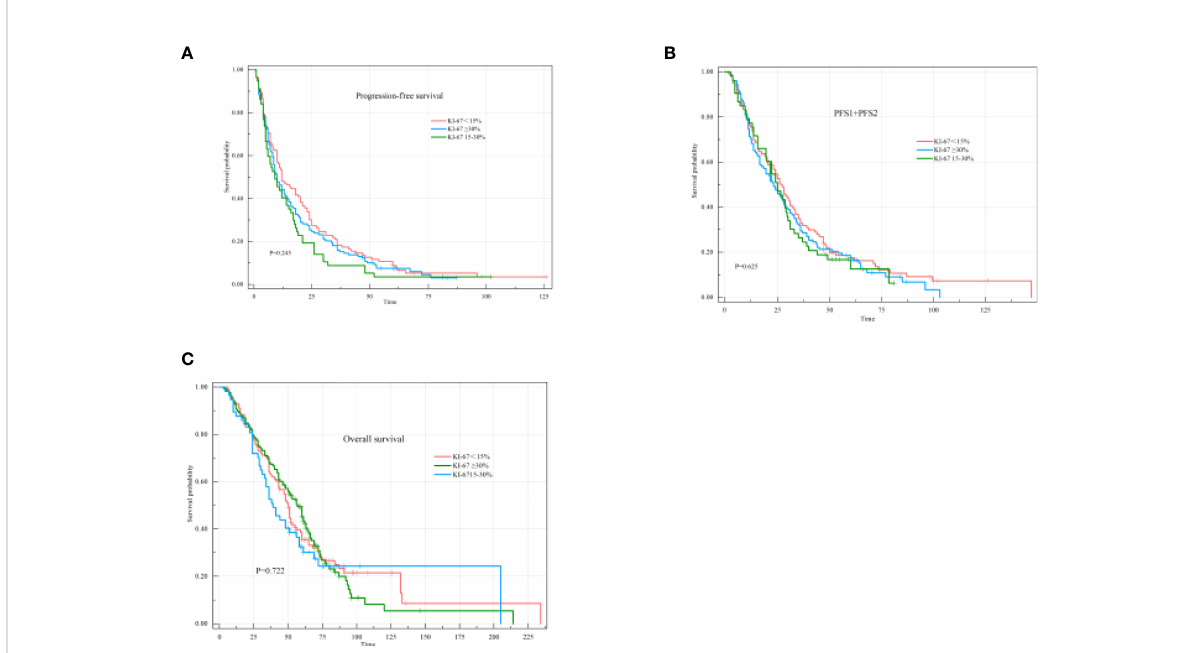
FIGURE 8 PFS1, PFS1+PFS2, and OS of different states according to the KI-67 index. (A) Kaplan – Meier curve of PFS1 in different states according to the KI- 67 index. (B) Kaplan – Meier curve of PFS1+PFS2 in different states according to the KI-67 index. (C) Kaplan – Meier curve of OS in different states according to the KI-67